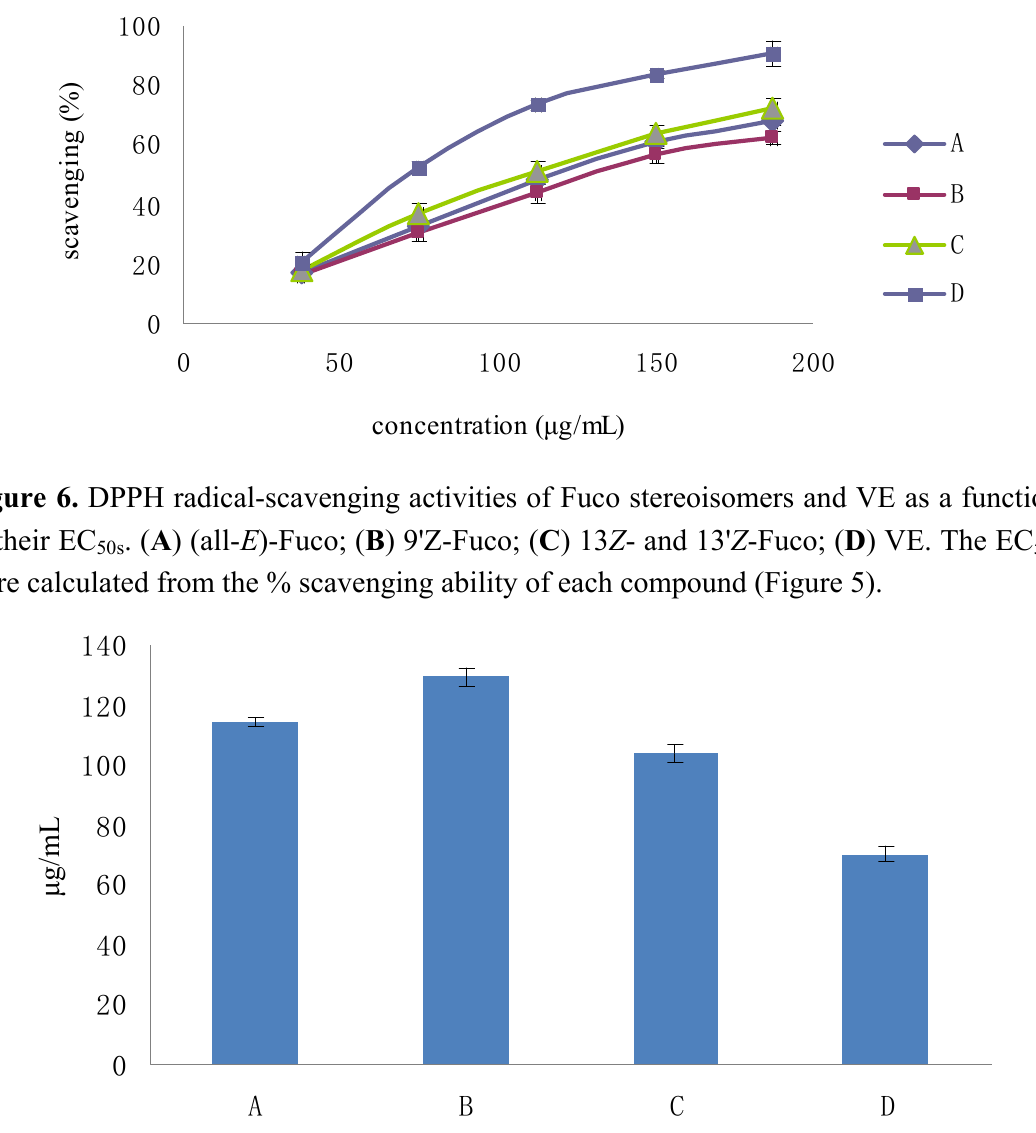
Figure 5. DPPH radical-scavenging activity of Fuco stereoisomers and VE. ( A ) (all- E )-Fuco; ( B ) 9' Z -Fuco; ( C ) 13 Z - and 13' Z -Fuco; ( D ) VE.